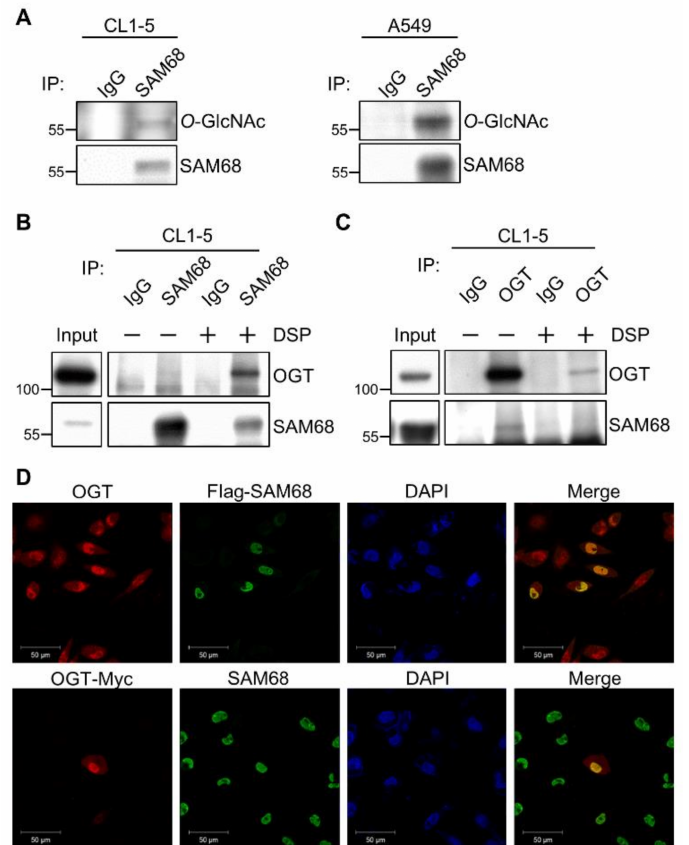
Figure 3. O -GlcNAcylation of SAM68 and its interaction with OGT. ( A ) O -GlcNAc Western analysis of immunoprecipitated SAM68. Total lysates from CL1-5 and A549 cells were subjected to immunopre- cipitation with anti-SAM68 or IgG antibodies and subsequent Western blotting using the antibodies indicated. ( B , C ) Co-immunoprecipitation. Lysates from CL1-5 cells treated with or without the cross- linker DSP were subjected to immunoprecipitation using anti-SAM68 ( B ) or anti-OGT ( C ) antibodies, and immunoprecipitated proteins were analyzed by Western blotting with indicated antibodies. ( D ) Immunofluorescence cell staining. CL1-5 cells transiently expressing Flag-tagged SAM68 or Myc-tagged OGT were fixed and subjected to immune-staining using primary antibodies recognizing OGT, Flag, Myc, and SAM68 as indicated; DAPI was used to stain cell nuclei. Micrographs were captured under a fluorescence confocal microscope. Detailed information about the Western blotting can be found at Figure S9. OGT, O -GlcNAc transferase; DSP, dithiobis (succinimidyl